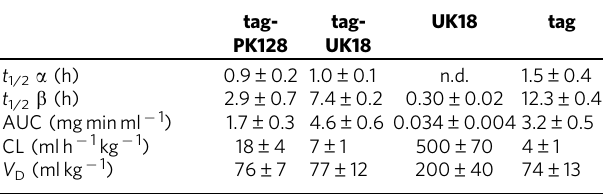
AUC, area under curve; CL, clearance; n.d., not determined; V D , volume of distribution. n ¼ 3 per peptide. Average values and s.d.’s are